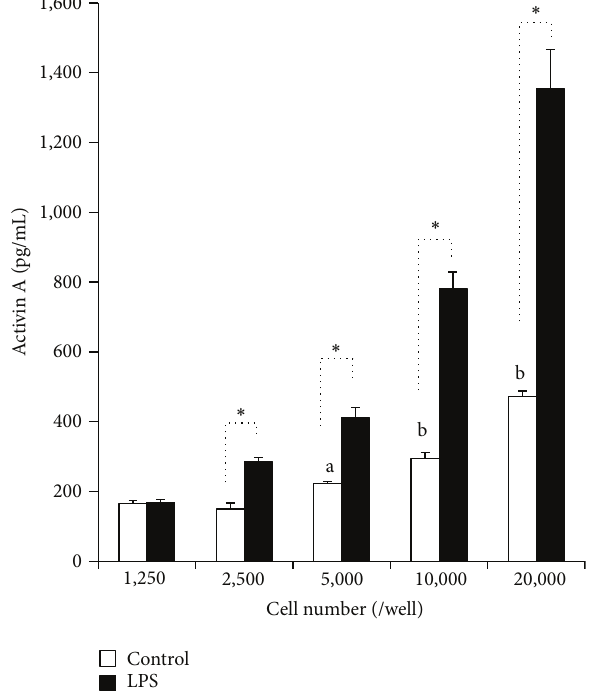
Figure 1: Effect of LPS on activin A secretion at various densities of AEC. Human AEC were seeded in 96-well microplates at densities of 1,250, 2,500, 5,000, 10,000, and 20,000 cells per well in 200 𝜇 L of DME/Ham’s F12 medium supplemented with 10% FBS, 100 𝜇 g/mL streptomycin,and0.5 𝜇 g/mLamphotericinB.EitherLPS(10 𝜇 g/mL) or vehicle (control) was added to each well. After 96 h of culture, activin A in the medium was measured. Closed rectangles: LPS. Open rectangles: control. The results from the quadruplicate assay are shown as the mean ± SE ( 𝑛 = 4 ). a 𝑃 < 0.05 compared with the control value at 1,250 cells/well. b 𝑃 < 0.01 compared with the controlvalueat1,250cells/well. ∗ 𝑃 < 0.01 comparedwiththecontrol value at each cell